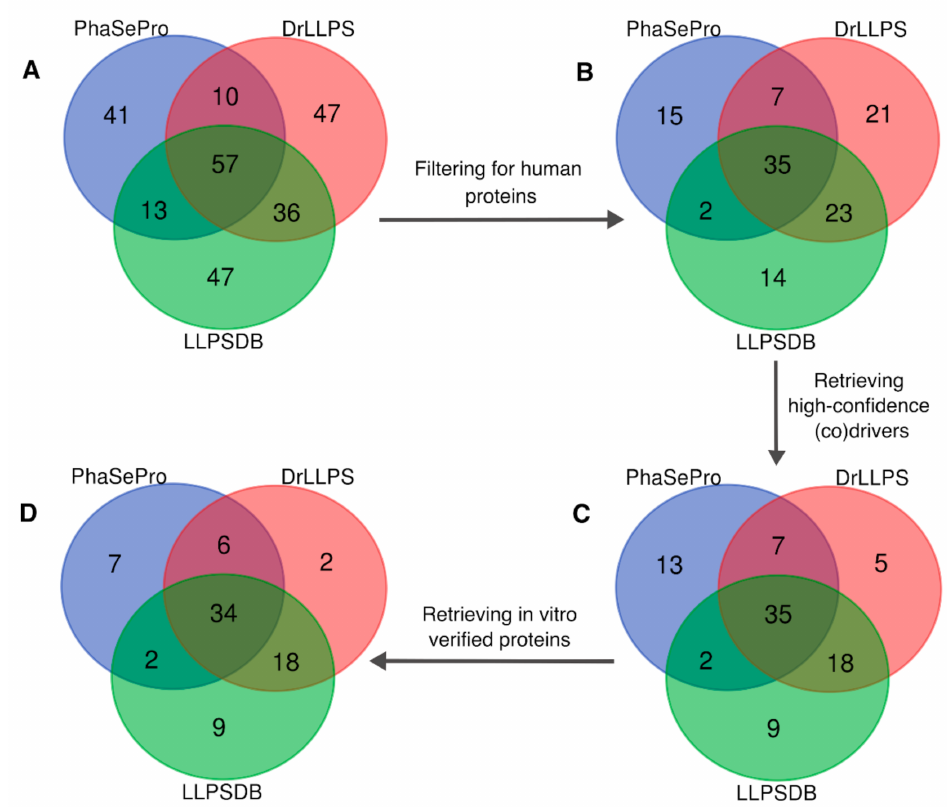
Figure 2. Filtering steps for obtaining a consolidated set of high-confidence human LLPS drivers. ( A ) Venn diagram representing the overlap of the three LLPS databases (251 proteins from PhaSePro, DrLLPS, and LLPSDB) after the exclusion of data in PhaSepDB. ( B ) Venn diagram representing the same overlap after filtering for human proteins (117 proteins). ( C ) Human proteins were further filtered for high-confidence (co)drivers by excluding those that could not be accepted as LLPS (co)drivers according to our definition of this role, resulting in a set of 89 proteins. ( D ) Among